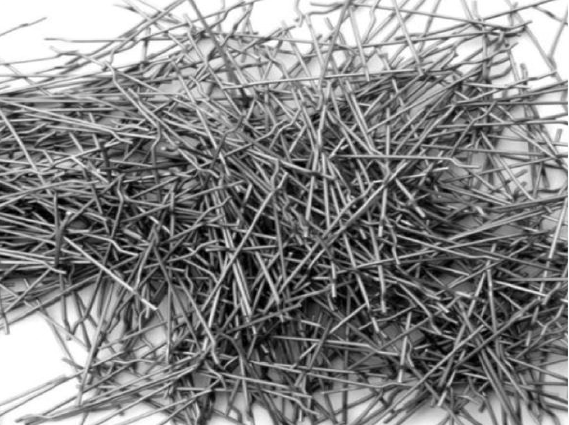
Figure 8. Steel fibers can be used for reducing cracking in concrete. Reprinted with permission from [70]. Copyright©2019, Elsevier B.V.